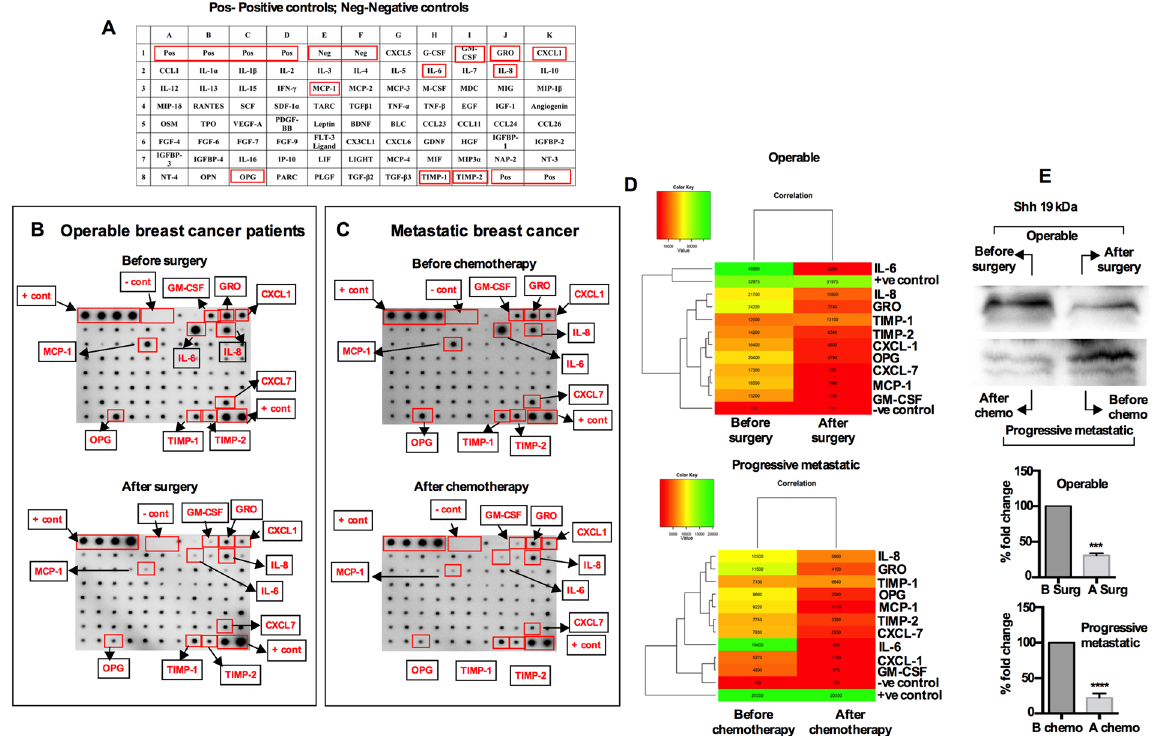
Figure 4. Cytokines in breast cancer patients’ serum. Array analysis of cytokines from breast cancer patient’s serum described in materials and methods. ( A ) Location and map of cytokine antibodies arranged and spotted on the membrane. Representative images of cytokine antibody arrays from ( B ) patients with early operable tumors before and after surgery, and ( C ) from progressive metastatic breast cancer patients before and after chemotherapy. Highlighted rectangles indicate the cytokines elevated. ( D ) Relative expressions of cytokines were determined by densitometer as described in materials and methods and presented as hierarchical clustering (red relatively low and green relatively high). Pos: positive controls, Neg: negative controls. ( E ) Western blot analysis of Shh in serum. Western blot analysis was performed from cohort of early operative (n = 29) and progressive metastatic (n = 20) breast cancer patients and a representative image shown in the figure. Molecular weight of Shh approximately 19 kDa; images shown here have been cropped to show the respective bands. Band densities were quantified with densitometry analysis using ImageJ64